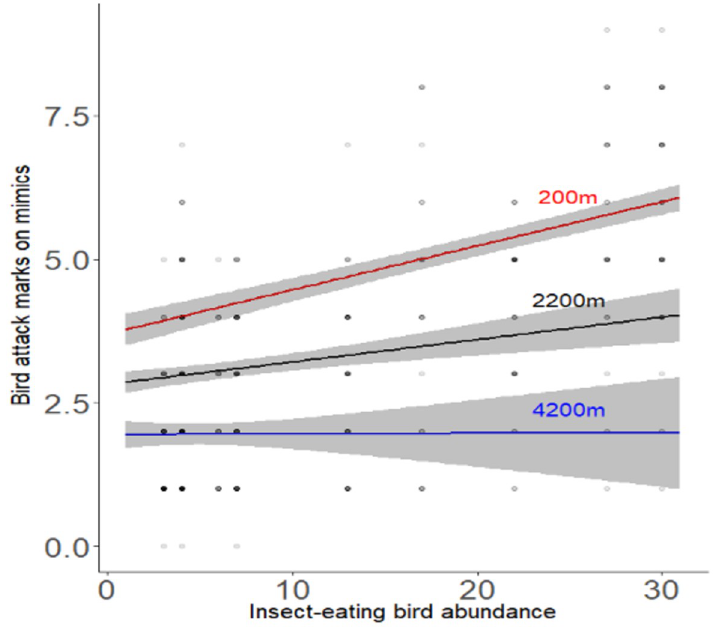
Fig 3. How the relationship between bird attack rates on prey mimics with insect-eating bird abundance varies with distance from a forest fragment. We estimated the predicted values from model in Table 1 and plotted the predicted lines. Crop was set to A and the colour to brown, and we plotted three separate lines for close distance at 200m, intermediate distance at 2200m and a far distance at 4200m. The gradient becomes less steep away from the forest fragments, showing that the positive effect of insect-eating bird abundance on prey mimics depends on proximity to forest.